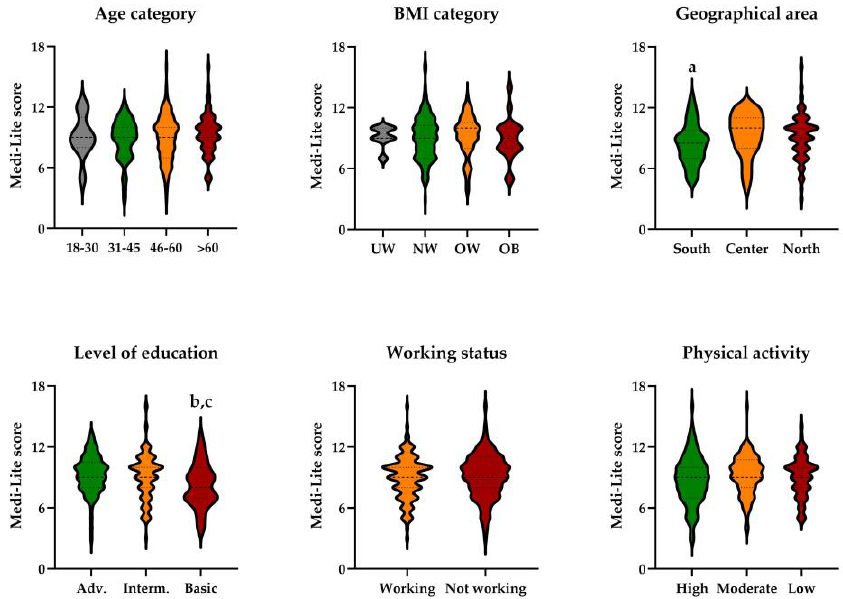
Figure 4. MEDI-LITE score by age category, body mass index (BMI) category, geographical area, level of education, working status and physical activity level in KT recipients. UW, underweight; NW, normal weigh; OW, overweight; OB, obesity; Adv, advanced; Interm., intermediate. a p = 0.031 vs. central Italy; b p = 0.016 vs. intermediate; c p = 0.006 vs. advanced level of education.